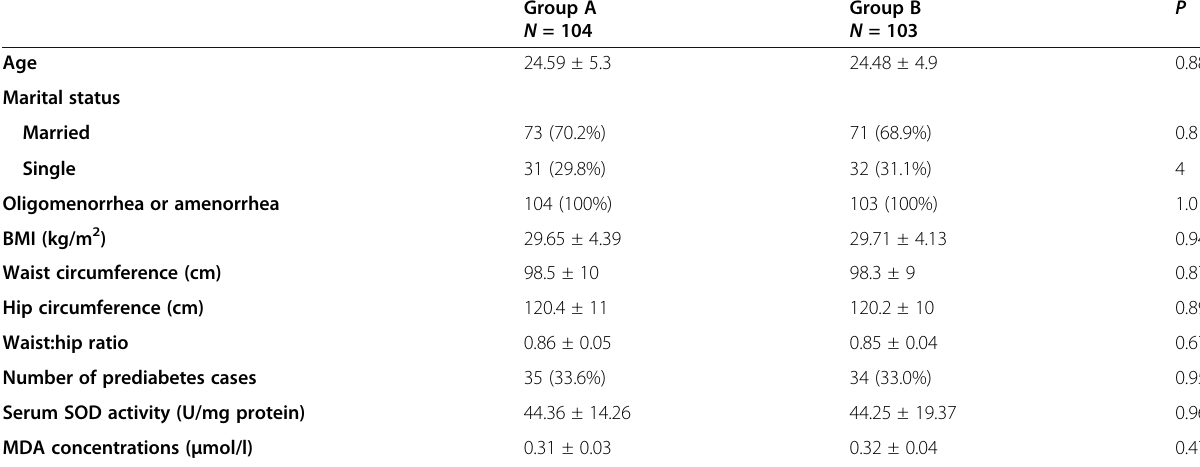
Table 1 Demographic and clinical data of the study population